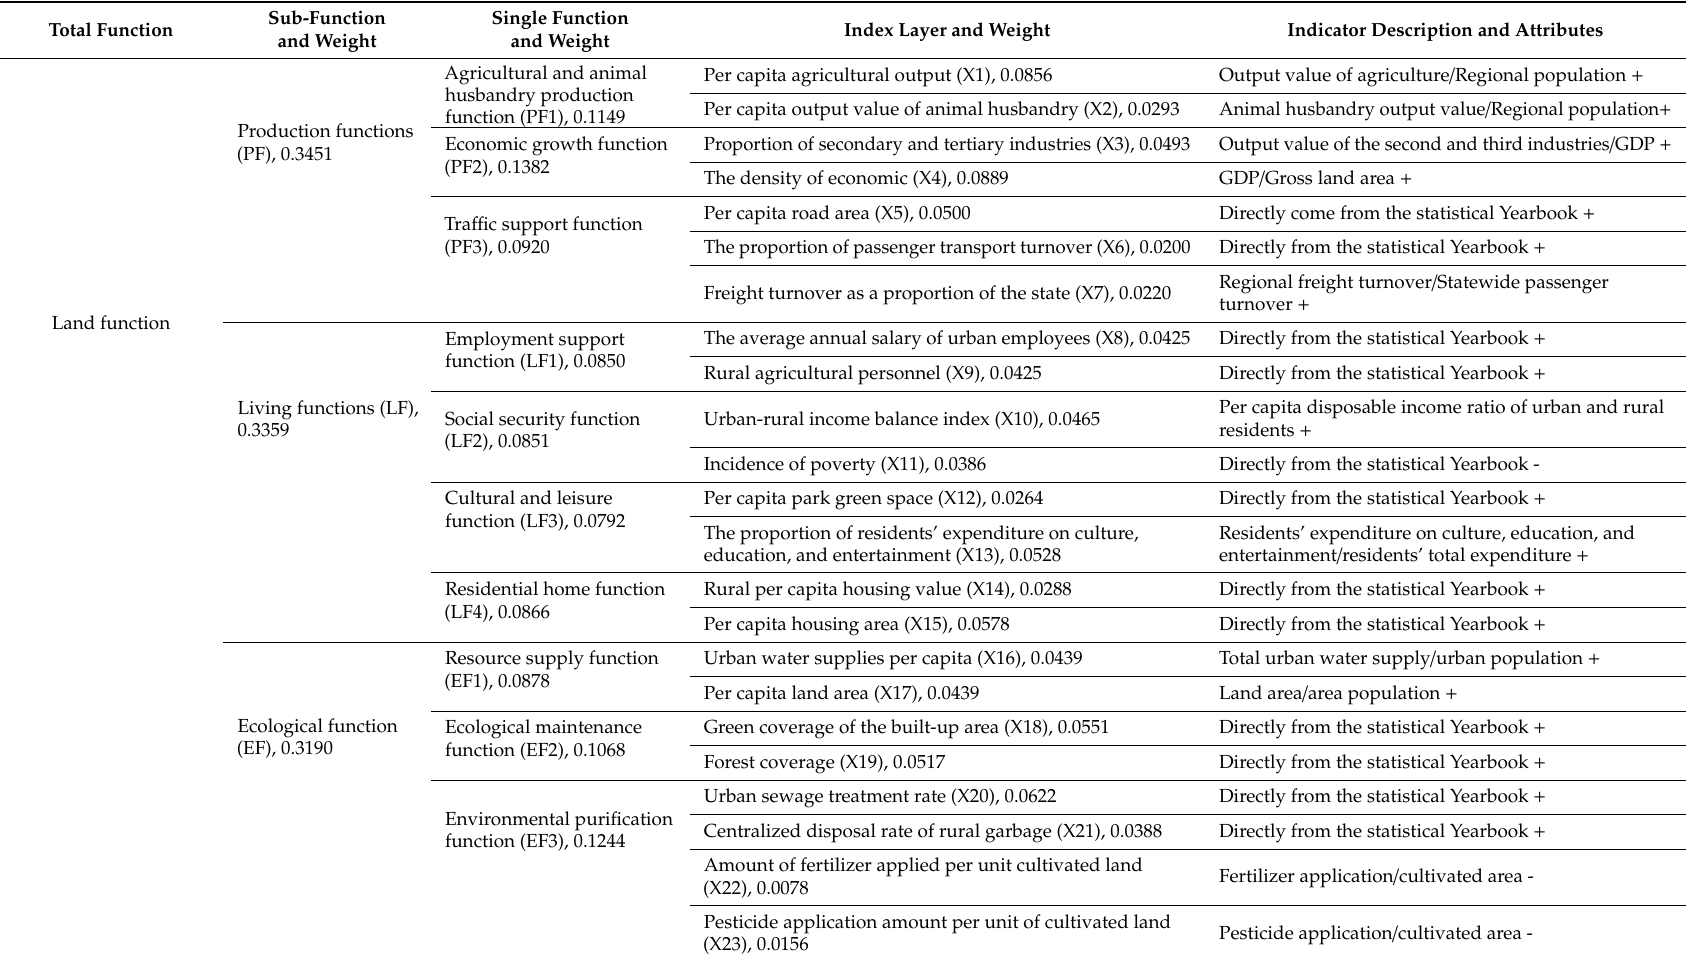
Table 2. Assessment indicator system of multi-functionality of land use in